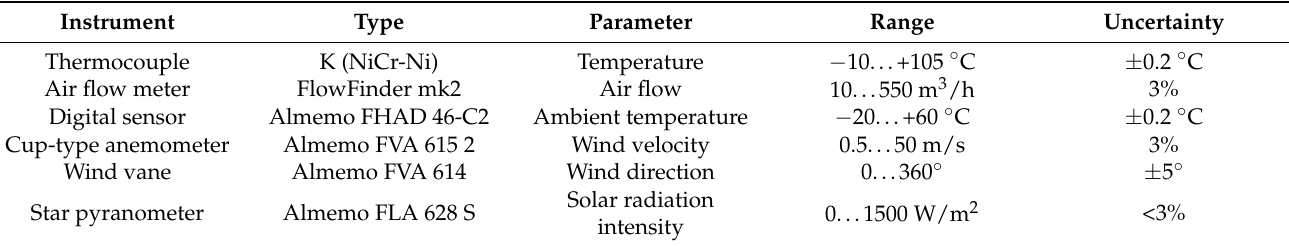
Table 1. Measuring devices ’ characteristics.